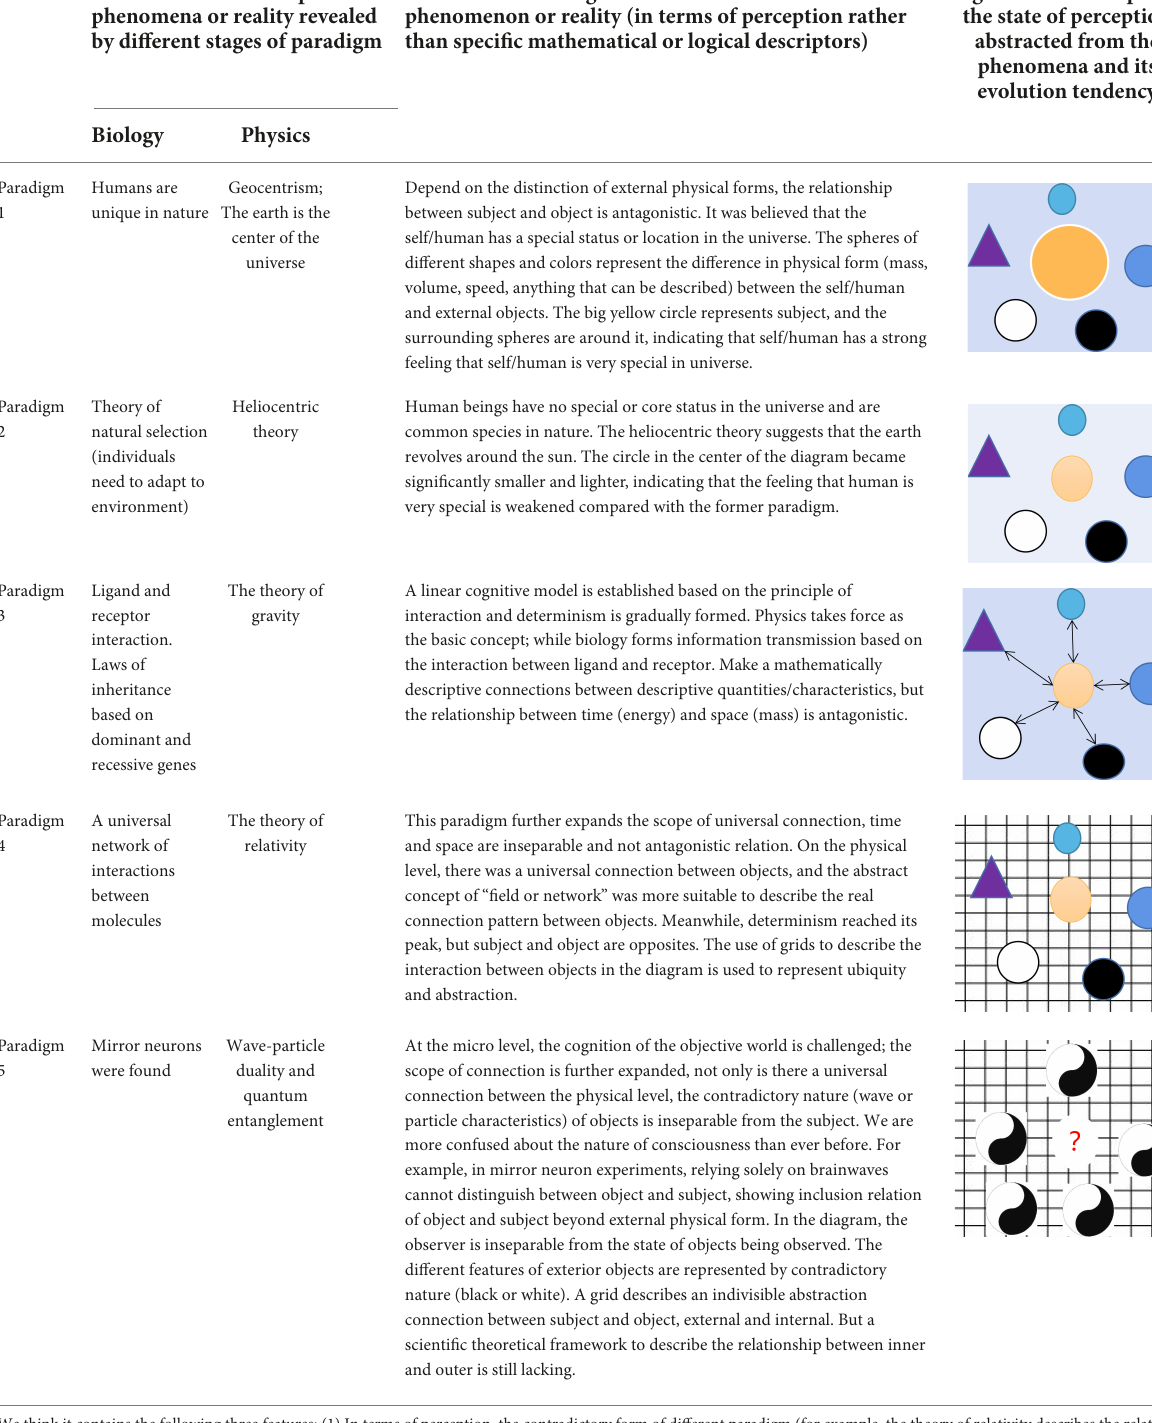
TABLE 1 The paradigms in different stages of scientific cognition show a regular tendency in terms of perception. Core theories listed represent The shared meaning abstracted from the revealed phenomena or reality revealed phenomenon or reality (in terms of perception rather by different stages of paradigm than specific mathematical or logical descriptors)